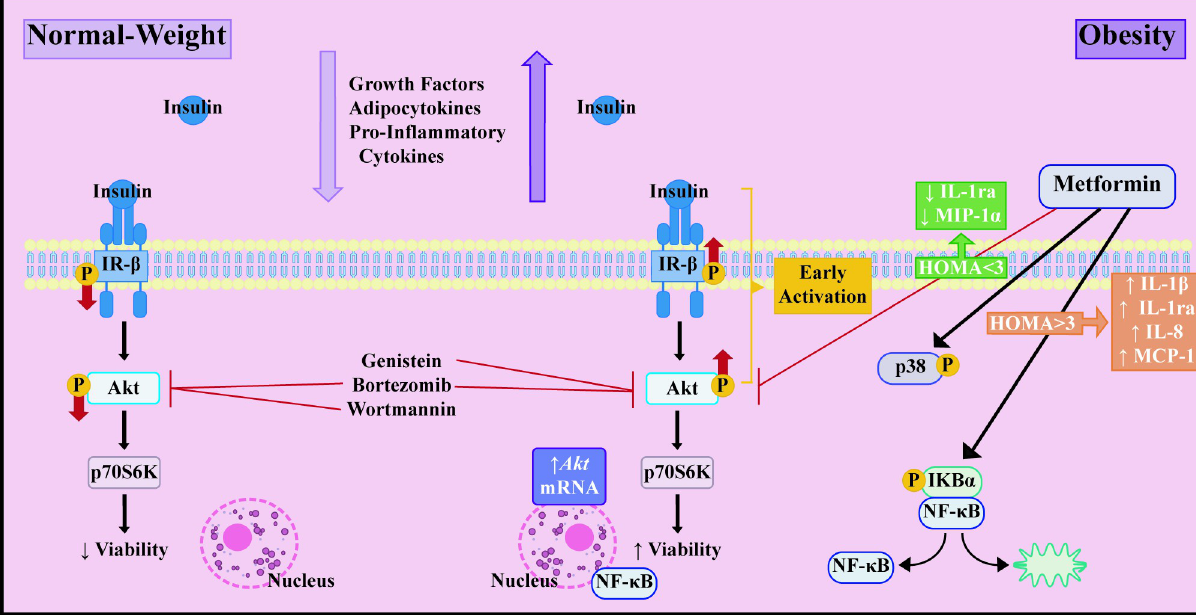
Fig 6. Schematic representation of the activation of the IR- β /Akt/p70S6K pathway in MCF-7 cells exposed to human sera with different metabolic characteristics and effect of Metformin treatment in obese patients.